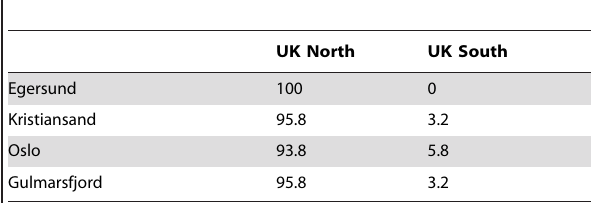
Table 6. Results of statistical assignment tests [42] over the North Sea genetic break.